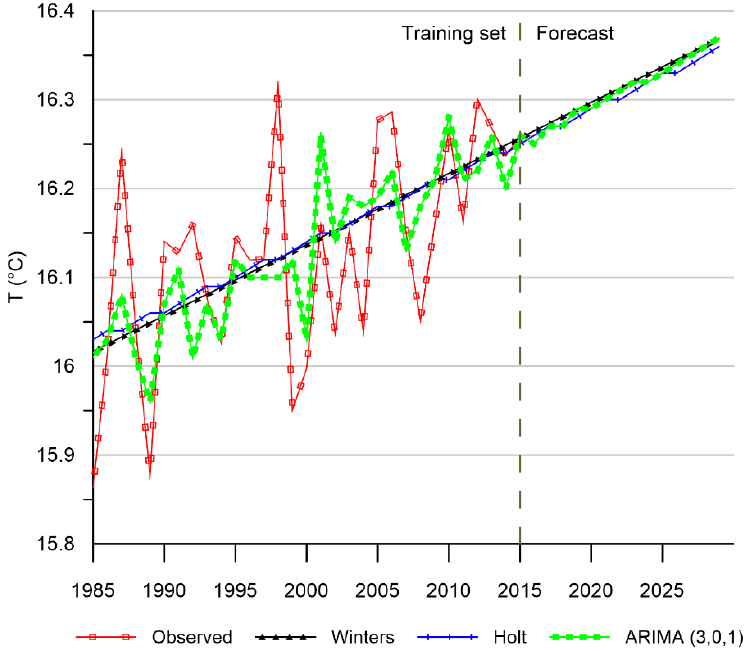
Figure 5. Annual average temperature forecast using ARIMA and exponential smoothing models. Table 6. Maximum rainfall recorded in 24 h of each month averaged by year, models, and adjust- ment statistics.